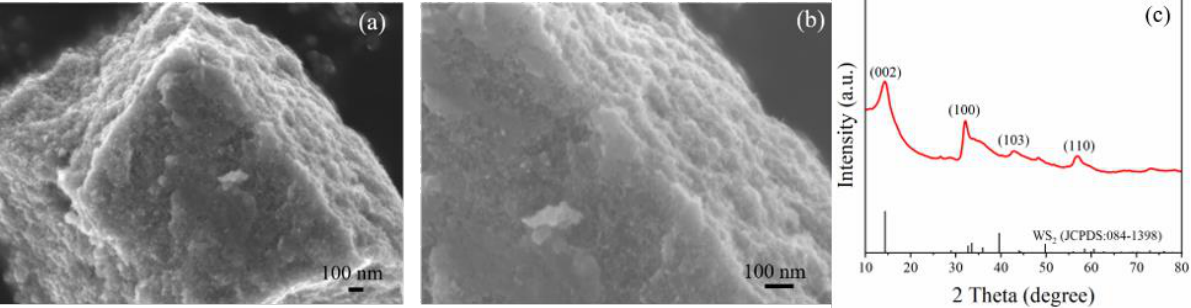
Figure 4. WS 2 ( a , b ) SEM images. ( c )